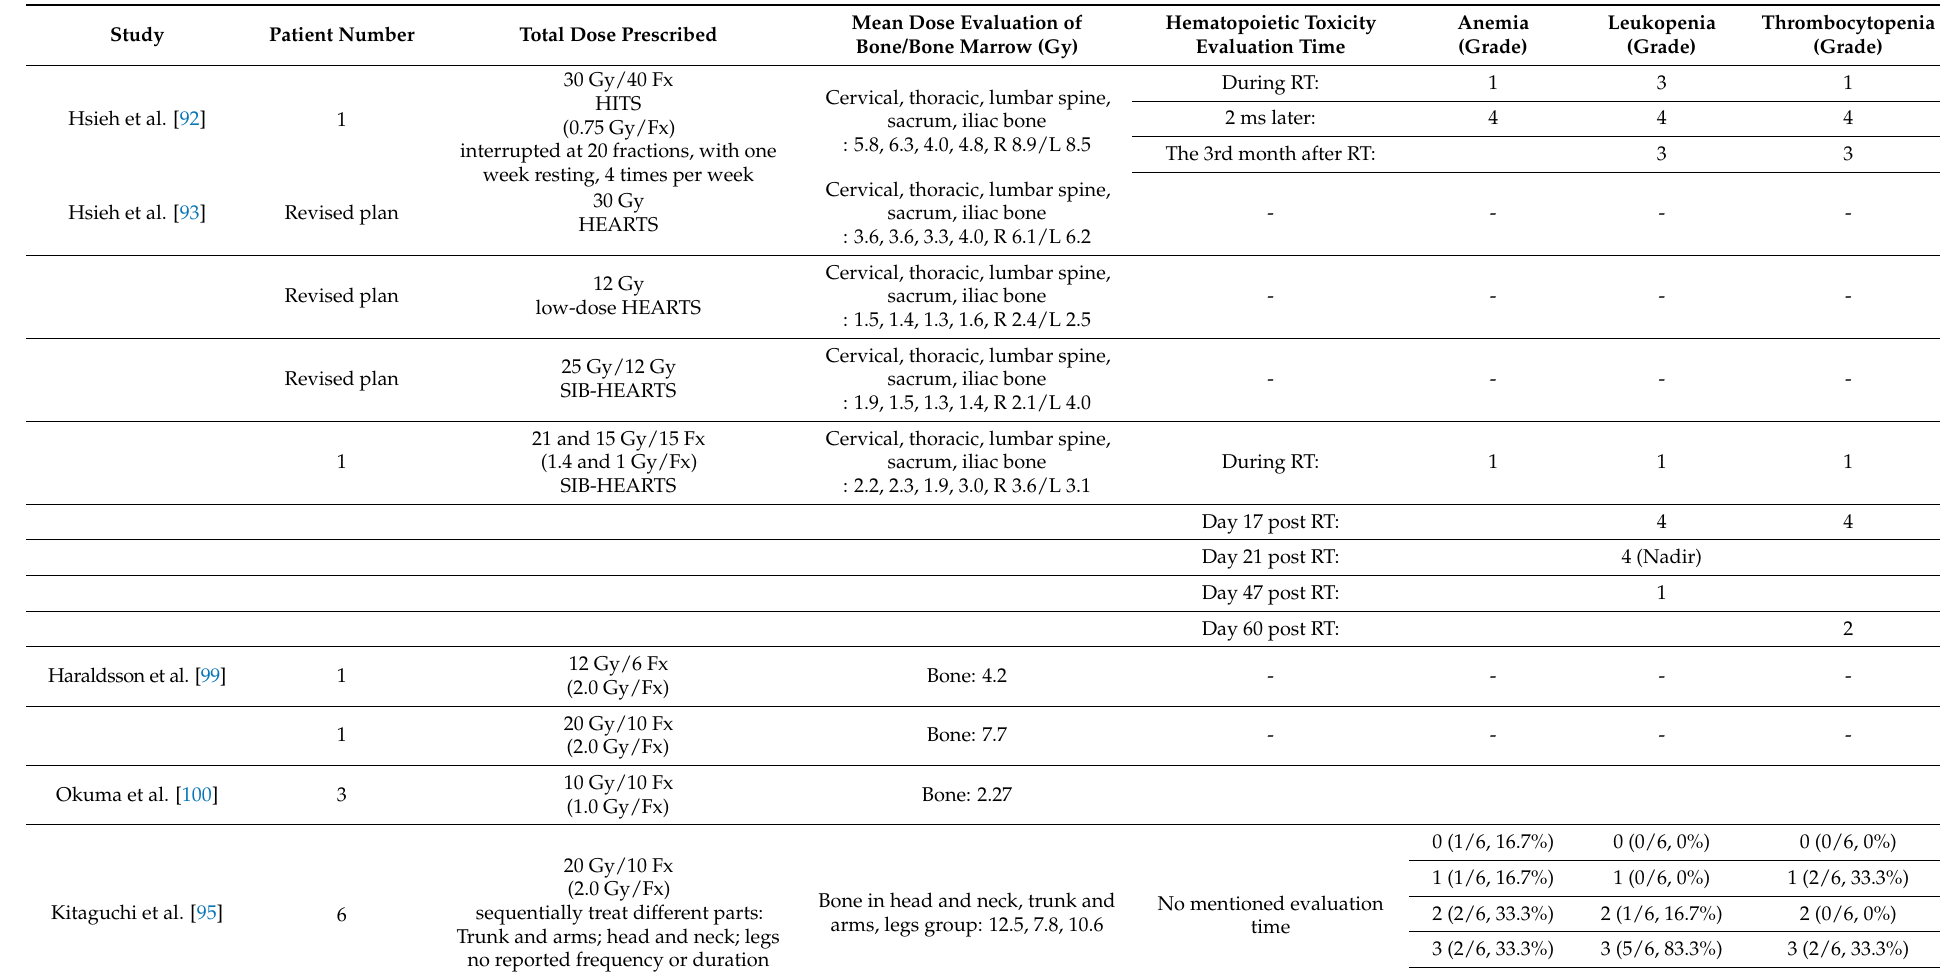
Table 3. Dose regimen, correlated bone/bone marrow dose evaluation, and hematopoietic toxicity for patients treated by helical arc radiotherapy of total skin (HEARTS) or other similar